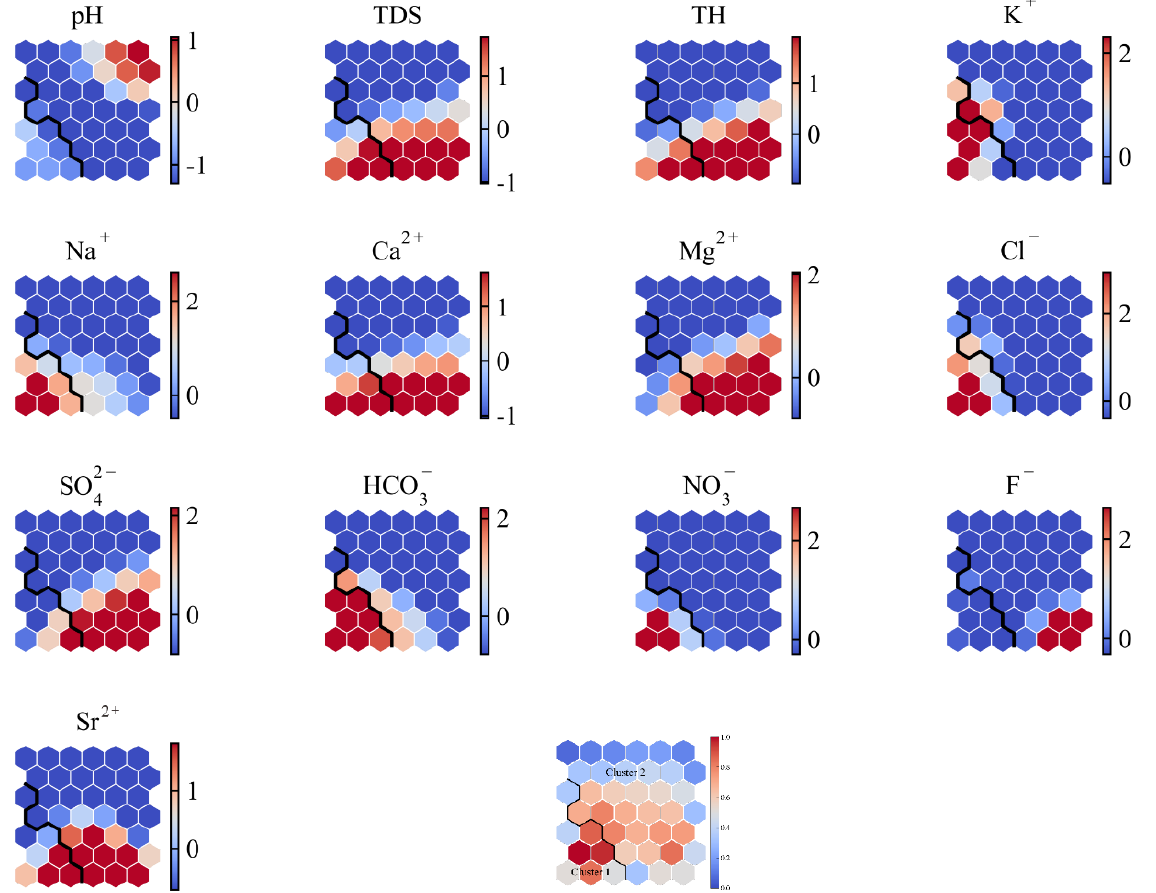
Figure 6. Characteristic map of main indicators of surface water and groundwater in the lower reaches of Yarlung Zangbo River mapped to SOM. Data are from Table 1.